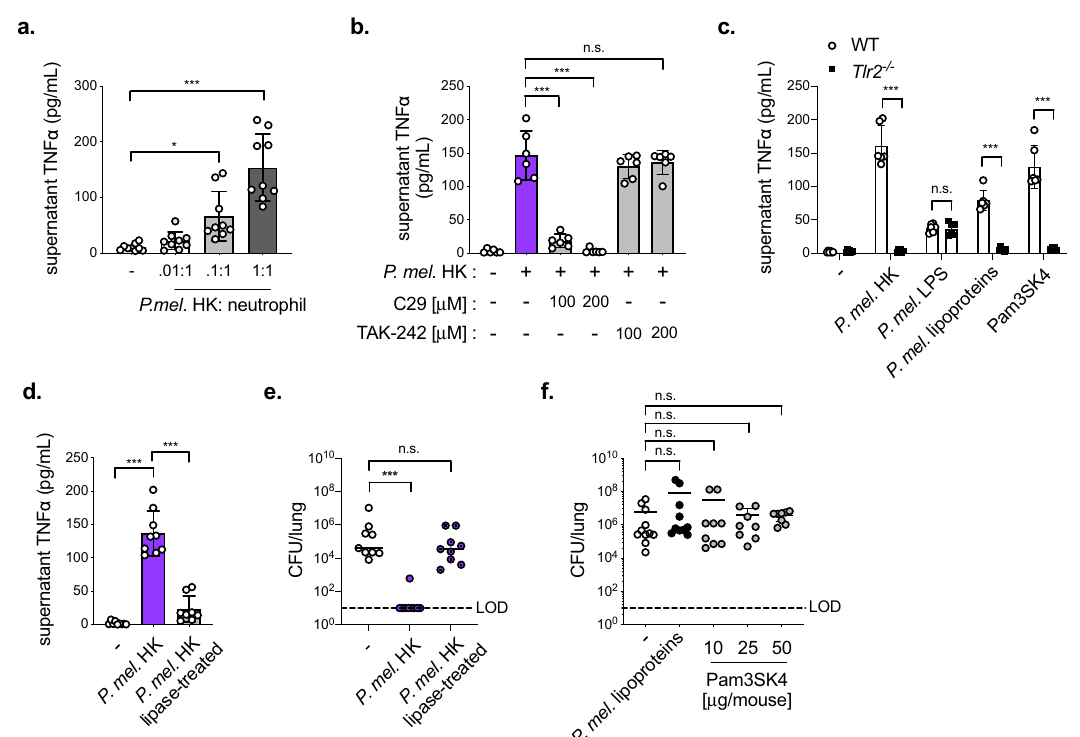
Fig. 5 P. melaninogenica ( P. mel .) lipoproteins induce neutrophil TNF α secretion in a TLR2-dependent manner. a Supernatant TNF α detected